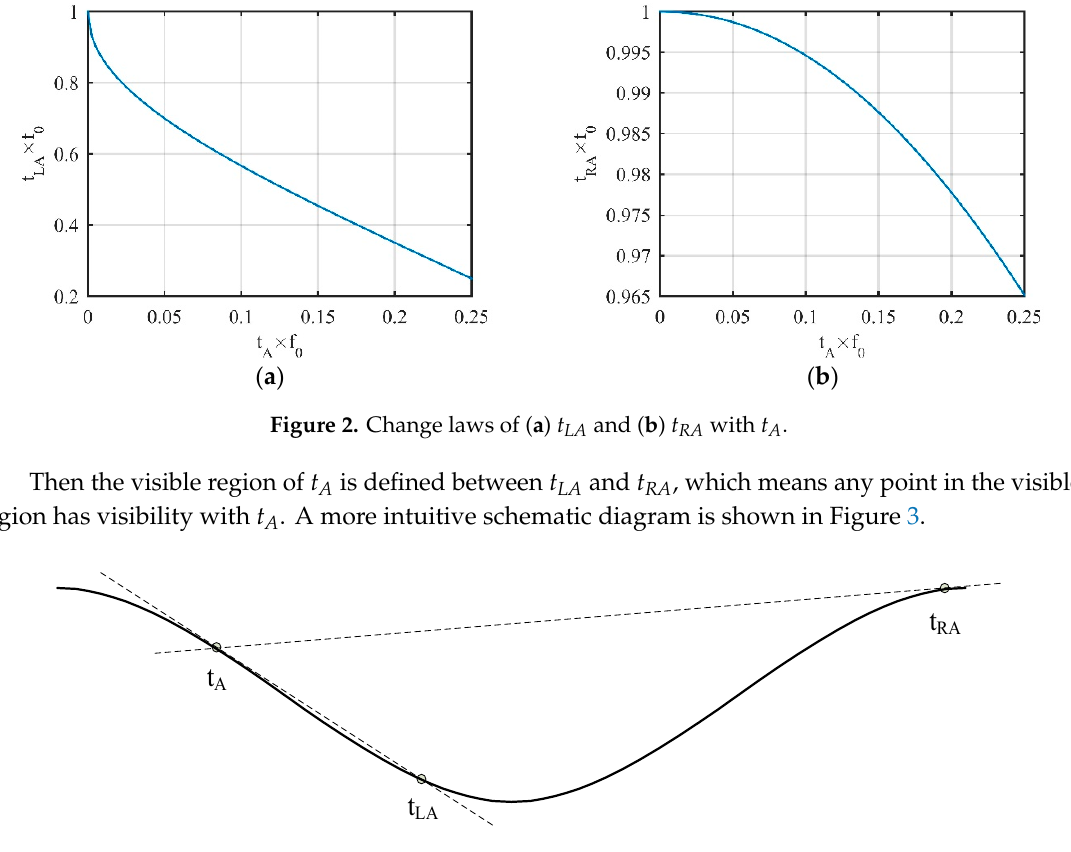
t . Figure 3. The visible region of t A . t . A A